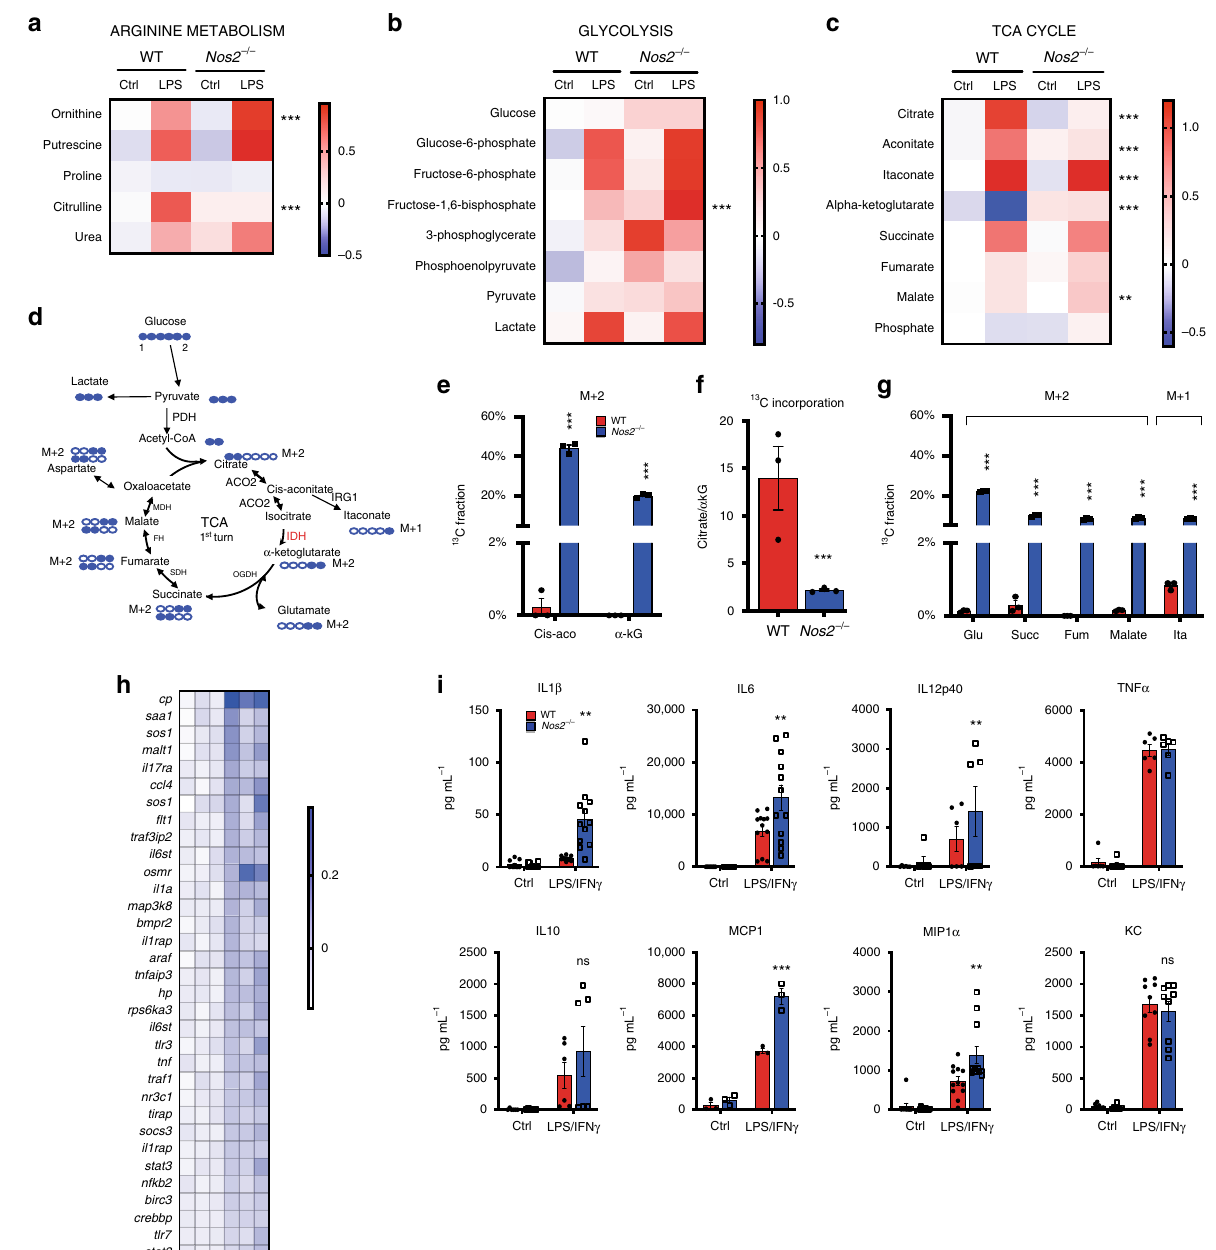
Fig. 1 Nos2 − / − macrophages show intact metabolism and in fl ammatory machinery. Heat-maps of the log10 ratio from the average peak areas from Gas Chromatography-Mass Spectrometry (GC-MS) analysis of metabolites associated with the arginine metabolism ( a ), glycolysis ( b ), and citric acid cycle ( c ) from bone marrow-derived macrophages (BMDMs) from wild-type (WT) and Nos2 − / − mice activated with LPS for 24 h compared to unstimulated (ctrl). d Schematic illustration of atom transitions in central metabolism using uniformly labeled 13 C-glucose ([U- 13 C]) (labeled carbons are indicated in blue) as tracer for determination of mass isotopologue distributions (MID) to infer relative intracellular fl uxes through oxidation of pyruvate. PDH pyruvate dehydrogenase, ACO2 aconitase 2, IDH isocitrate dehydrogenase, OGDH oxoglutarate dehydrogenase, SDH succinate dehydrogenase, FH fumarate hydratase, MDH malate dehydrogenase. e – g WT and Nos2 − / − BMDMs were activated with LPS + IFN γ and cultured with labeled tracer. Bars show evaluation of the [U- 13 C] glucose-derived carbon incorporation (percentage) into m + 2 isotopologues of the indicated TCA intermediates. e Percentage of 13 C in m + 2 isotopologues of cis-aconitate (cis-aco) and α -ketoglutarate ( α -kG). f Bar graph depicting the ratio between citrate and α -kG for 13 C fraction of the total metabolite level. g m + 2 isotopologues of glutamate (glu), succinate (succ), fumarate, malate and in m + 1 itaconate (ita) in activated WT and Nos2 − / − BMDMs. Data in a – c ( n = 5 biological replicates per group) and e – g ( n = 6) were analyzed by two-way ANOVA (interaction < 0.0001) (Sidak ’ s post-tests). h Expression pro fi le of selected in fl ammatory genes from microarray analysis (see Table1) shown as heatmap of log2 fold changes of LPS + IFN γ -stimulated Nos2 − / − BMDMs compared to WT ( n = 3). I The concentration of IL1 β , IL6, IL12p40, TNF α , IL10, MCP1, MIP1 α , and KC secreted into the culture media when BMDMs were stimulated for 24 h. Data are pooled from three experiments ( n = 7 – 8) and were analyzed by two-way ANOVA with Sidak ’ s post-tests. All error bars display mean ± SEM. Source data are provided as a Source Data fi